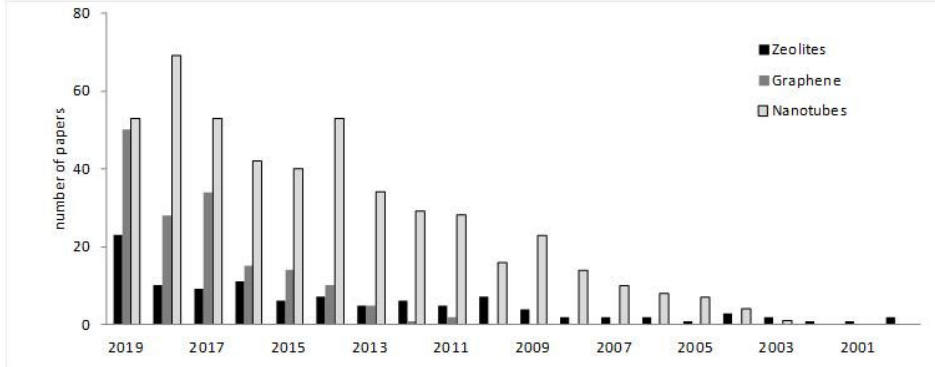
Figure 2. Tentative number of papers published during the last two decades. The number of papers has been calculated on the basis of a search including each word (zeolite, graphene or nanotubes) and dental or dentistry, according to Scopus.